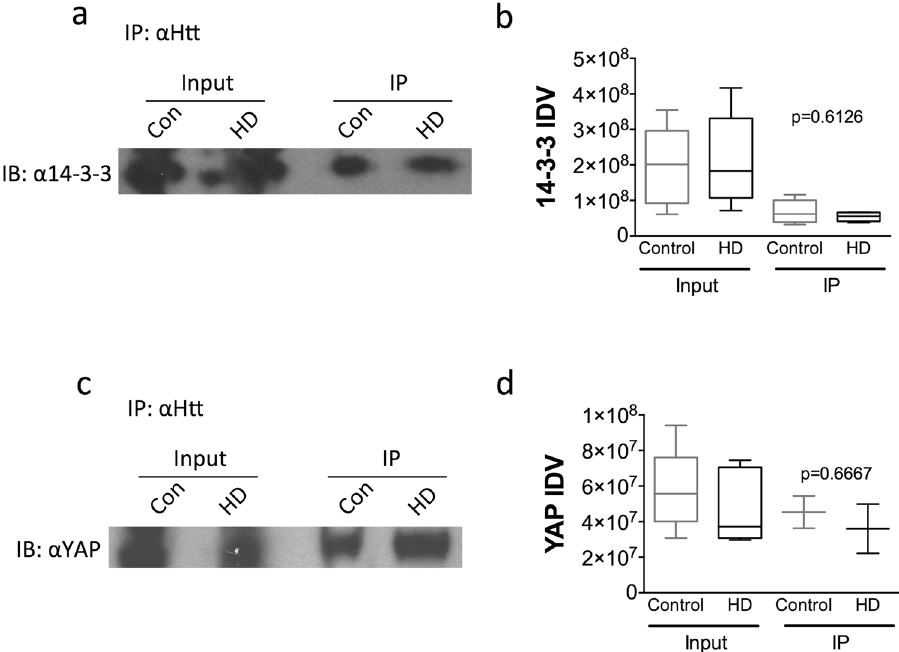
Figure 4. YAP-Htt-14-3-3 interactions. ( a ) Representative blot from a co-immunoprecipitation assay using human cortex with anti-14-3-3 antibody followed by immunoblotting with an anti-huntingtin (2166) antibody. ( b ) There was no change in 14-3-3 levels in the input samples (left) (p = 0.7209, Mann-Whitney U Test) or in 14-3-3/Htt interactions (right) in HD cortex (black; n = 8 input and IP) compared to control (grey; n = 8 input, n = 7 IP) as demonstrated in the IP samples (p = 0.6126, Mann-Whitney U Test). ( c ) Representative blot from a co-immunoprecipitation assay using human cortex with anti-YAP antibody followed by immunoblotting with an anti-huntingtin (2166) antibody. ( d ) There was no change in YAP levels in the input samples (left) (p = 0.1031, Mann-Whitney U Test) in HD cortex (black; n = 7) compared to control (grey; n = 7) or in YAP/Htt interactions (right) (p = 0.6667, Mann-Whitney U Test) in HD cortex (black; n = 7) compared to control (grey; n = 7) as demonstrated in the IP samples in HD cortex (black; n = 2) compared to control (grey; n = 2) (p = 0.6667, Mann-Whitney U Test). Data are presented as median and min-max